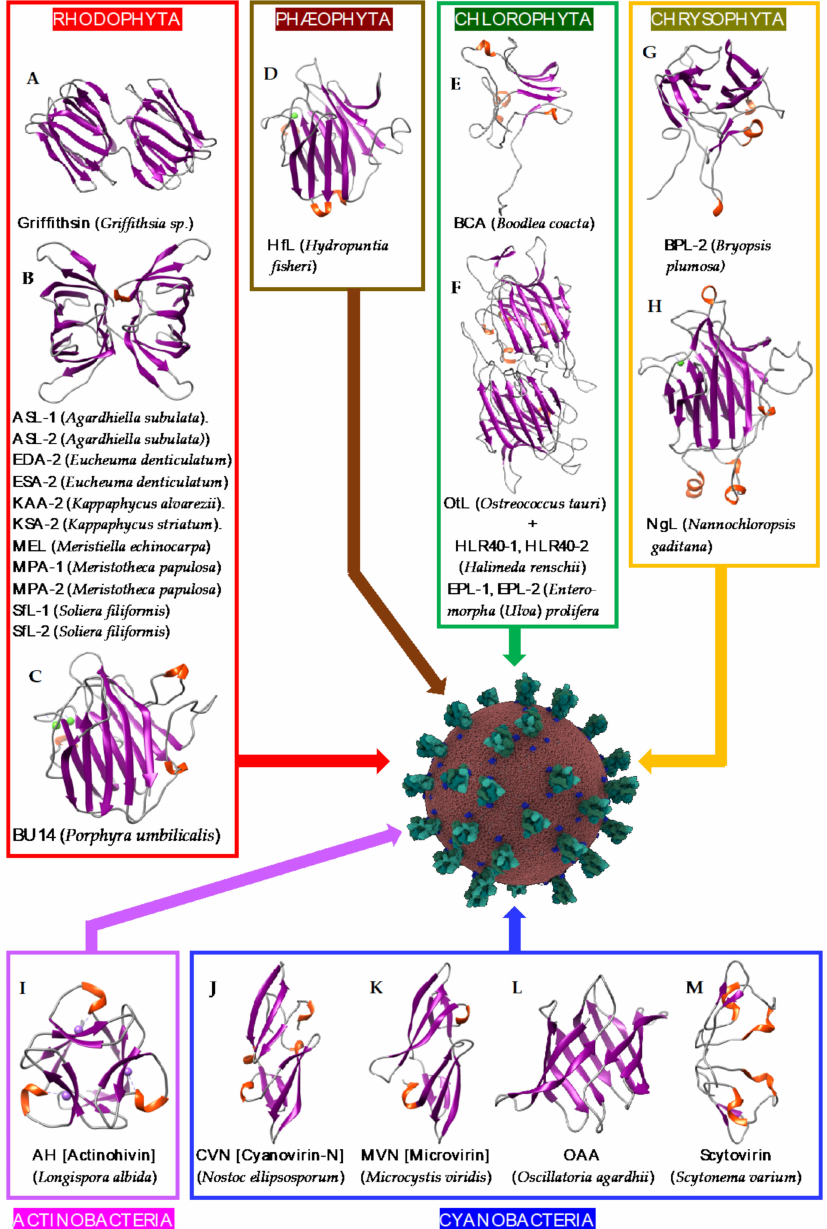
Figure 18. Overview of lectins from representative genera/species of algae and cyanobacteria, with their associated structural scaffolds, able to recognize the spike proteins from coronaviruses ( Coronavirus Credit: Maria Voigt/RCSB PDB). A-M correspond to lectins used as structural scaffolds (( A ): Griffithsin, ( B ): ASL-1, ( C ): BU14, ( D ): HfL, ( E ): BCA, ( F ): OtL, ( G ): BPL-2, ( H ): NgL, ( I ): Actinohivin, ( J ): CVN, ( K ): MVN, ( L ): OAA, ( M ): Scytovirin. References [28–30,112–129] correspond to the lectins presented in the